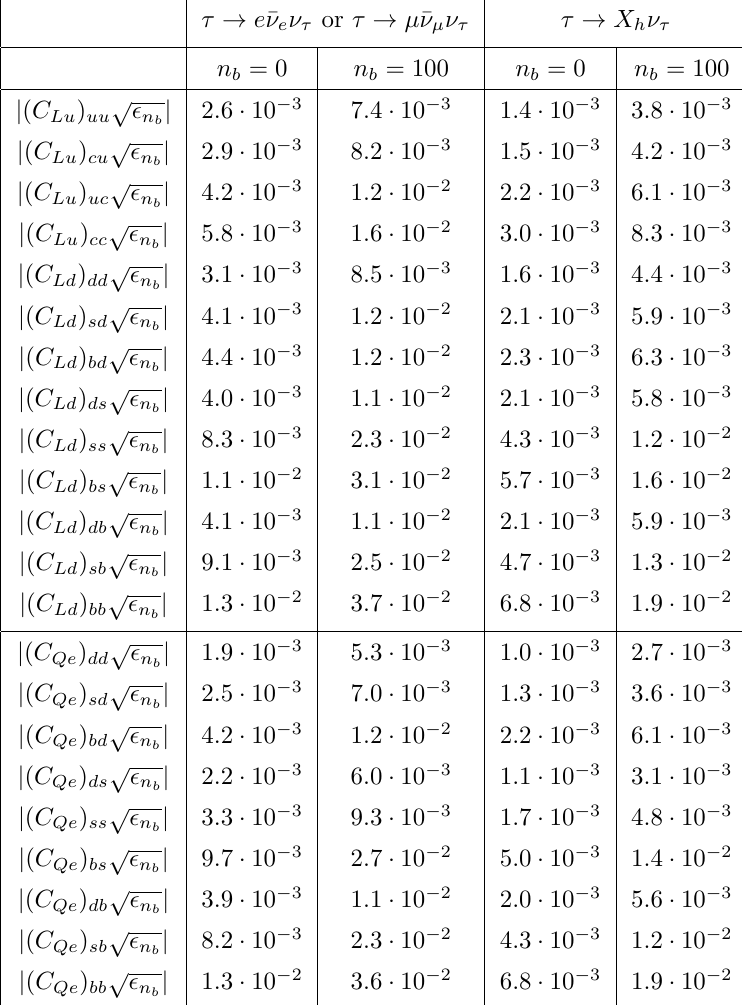
= 0 and n = n = 100 b b